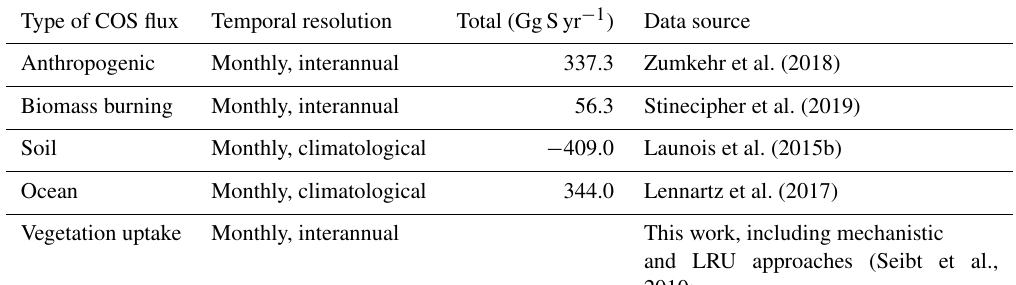
Table D1. Prescribed COS surface fluxes used as model input. Mean magnitudes of different types of fluxes are given for the period 2000–